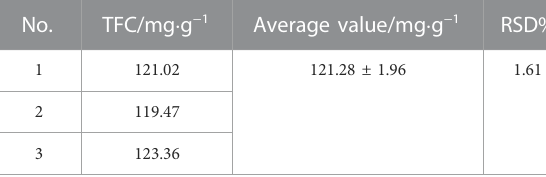
TABLE 2 Results of orthogonal experiment. No.